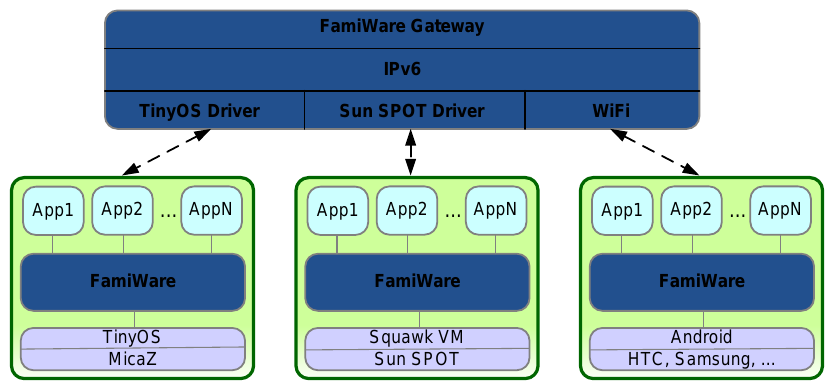
Figure 3. Device interconnection using FamiWare.